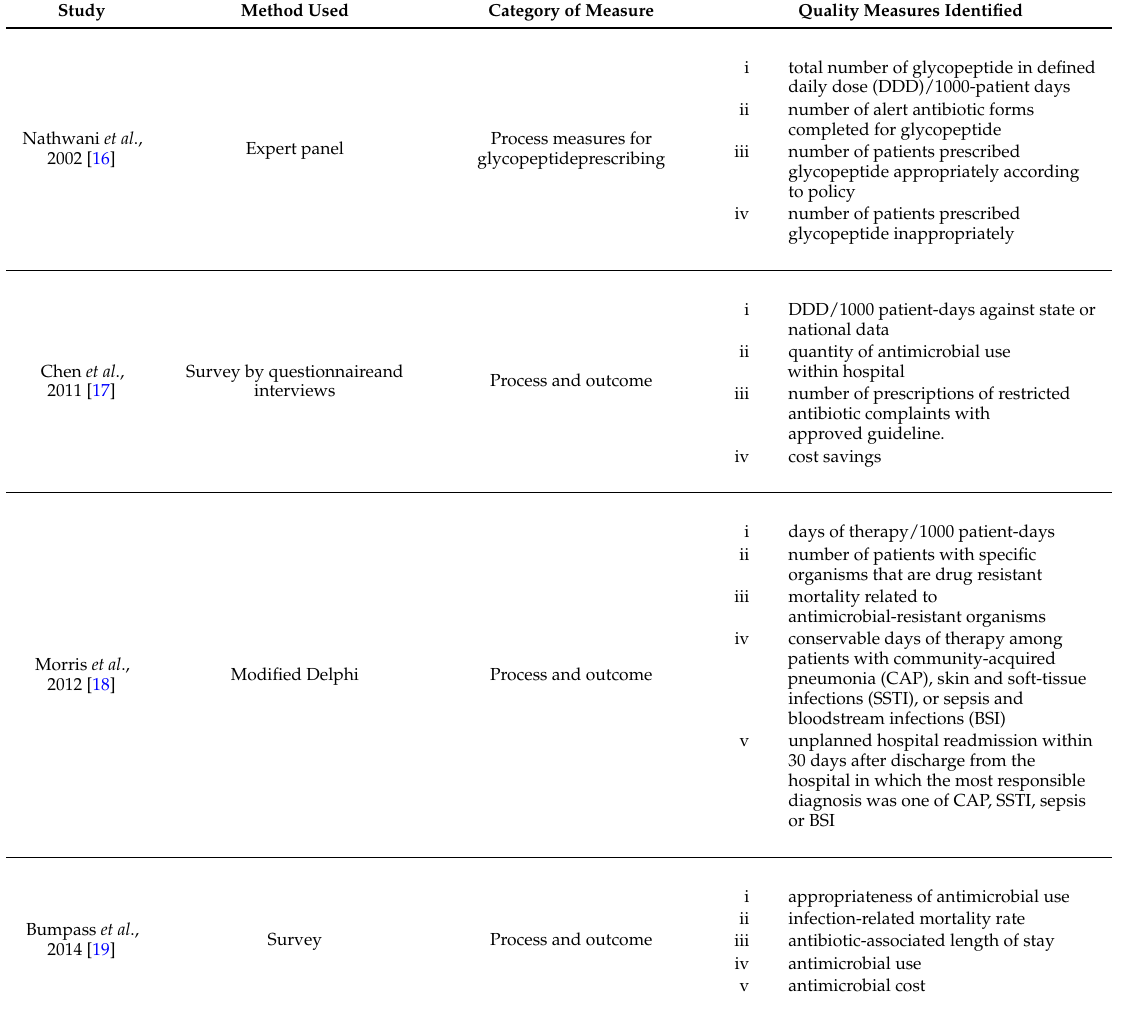
Table 1. Studies that defined quality measures for evaluating antimicrobial stewardship programs antimicrobial stewardship programs